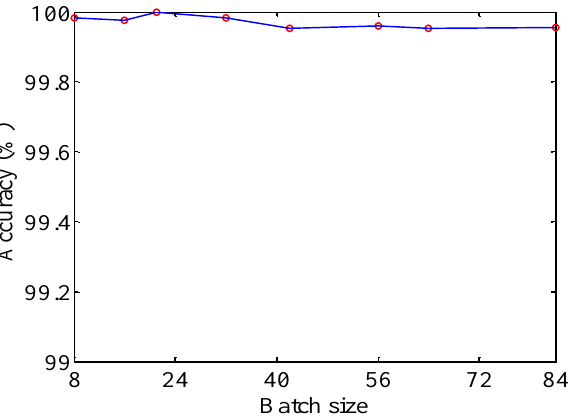
Figure 17. Relationship between classification accuracy and batch size.